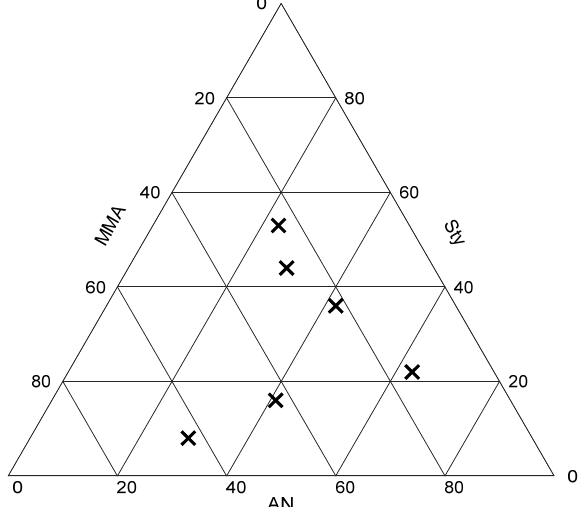
Figure 10. Terpolymerization feed compositions for AN / Sty / MMA. Data from [35].